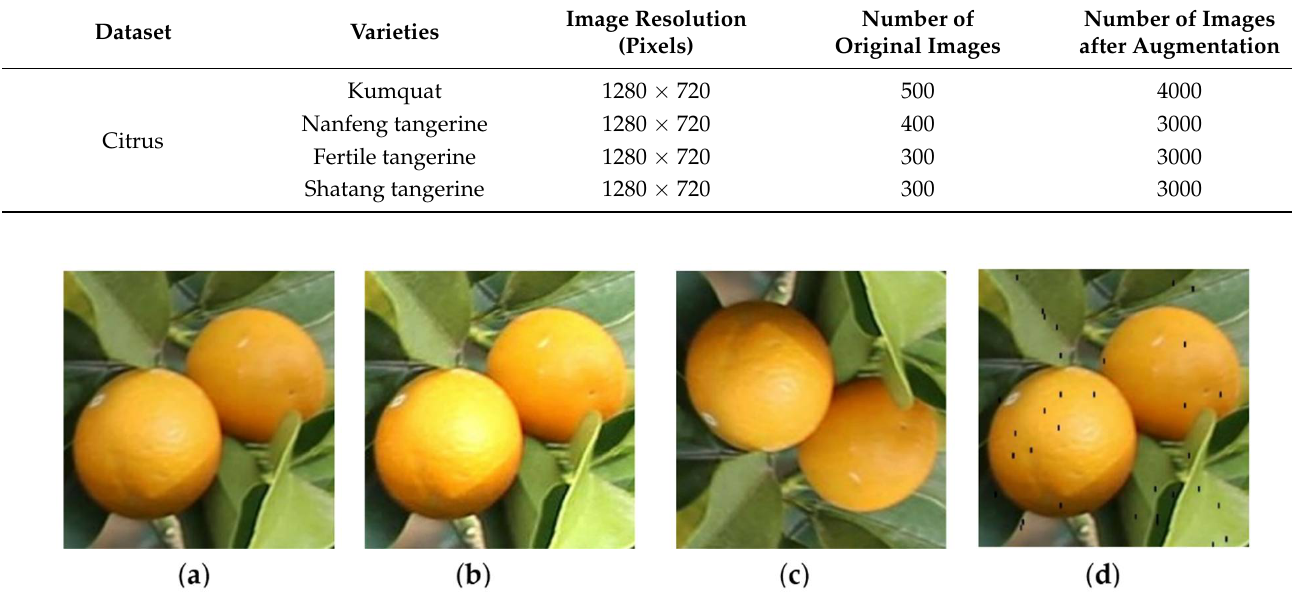
Figure 2. Image augmentation: ( a ) Original image; ( b ) brighten; ( c ) spin; ( d ) adding noise. Table 1. The details of the citrus